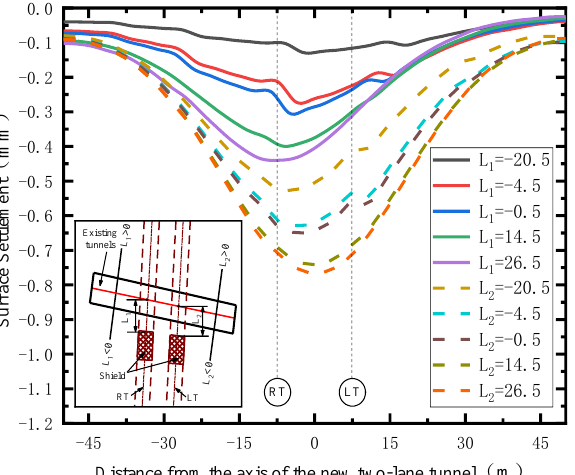
Figure 10. Ground settlement above the existing tunnel axis caused by tunnel excavation (considering the slurry hardening process).